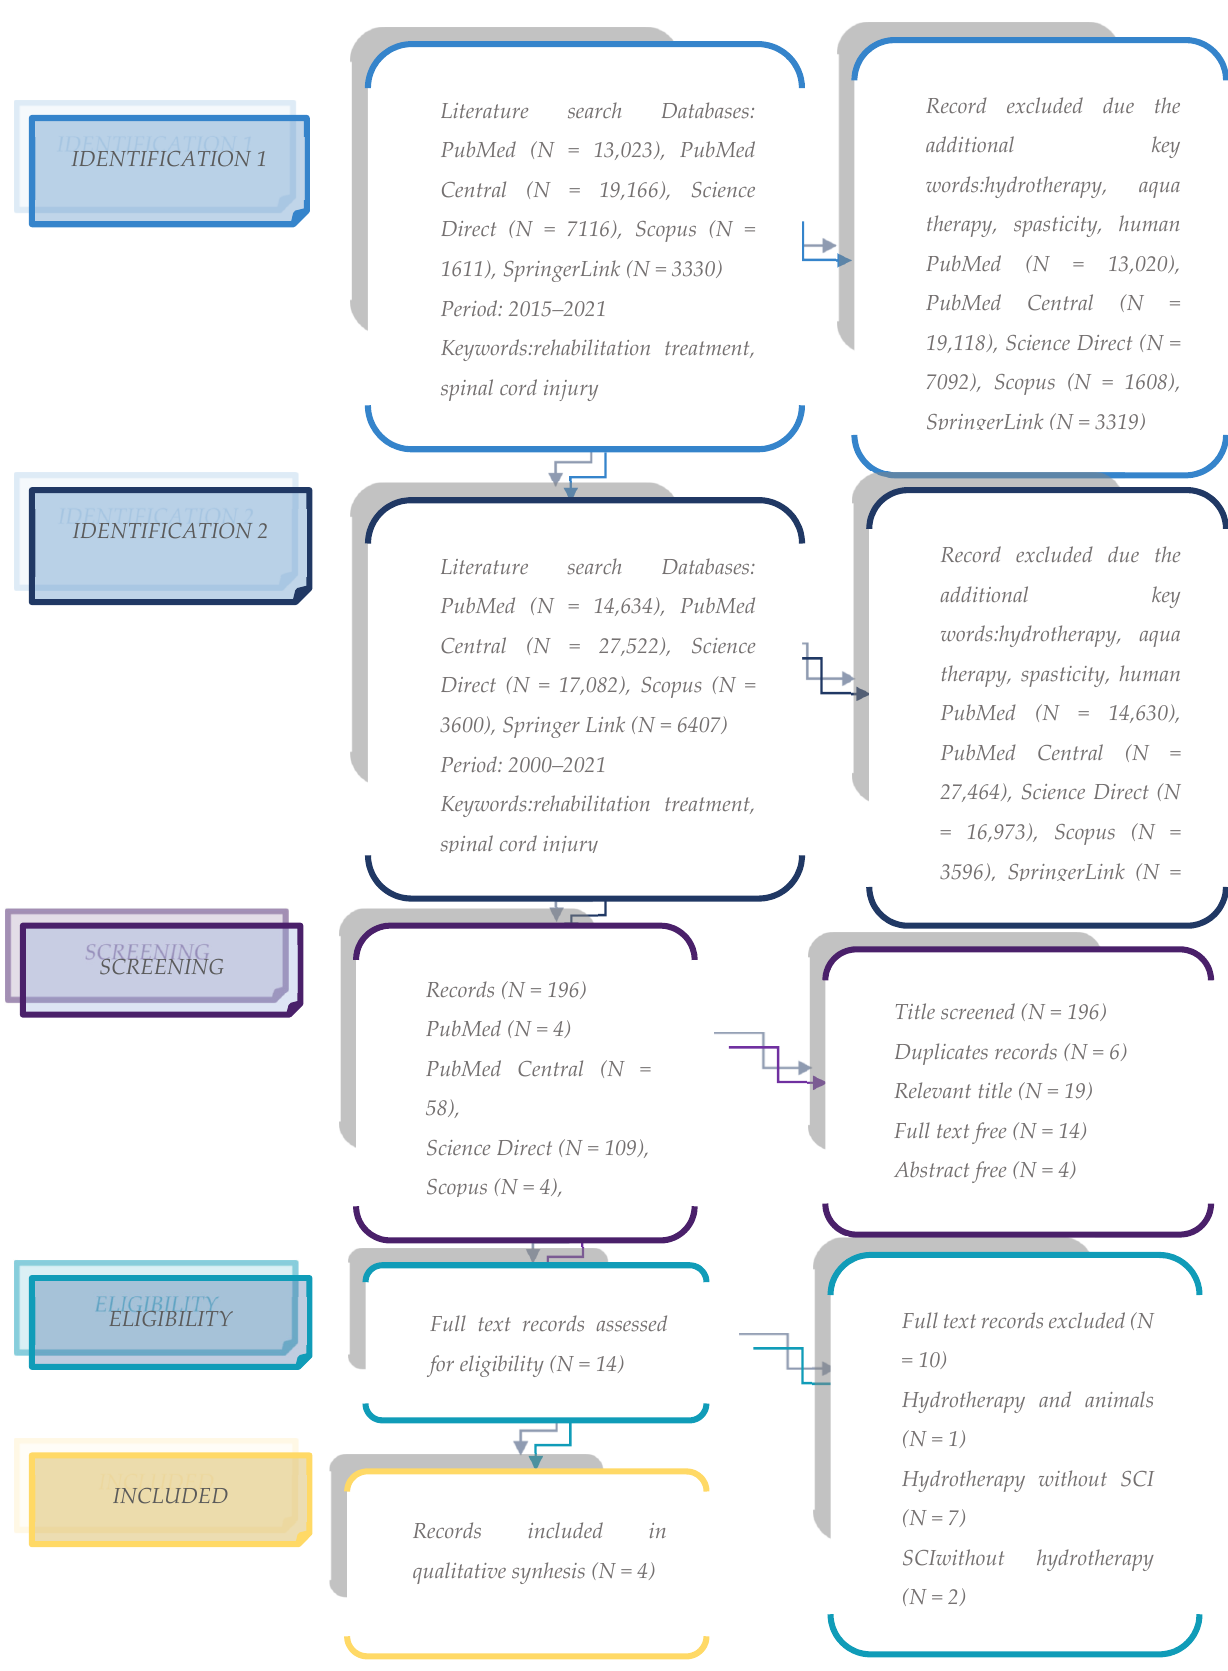
Figure 1. Flow chart of the review process. N—number of records; SCI—spinal cord injury.